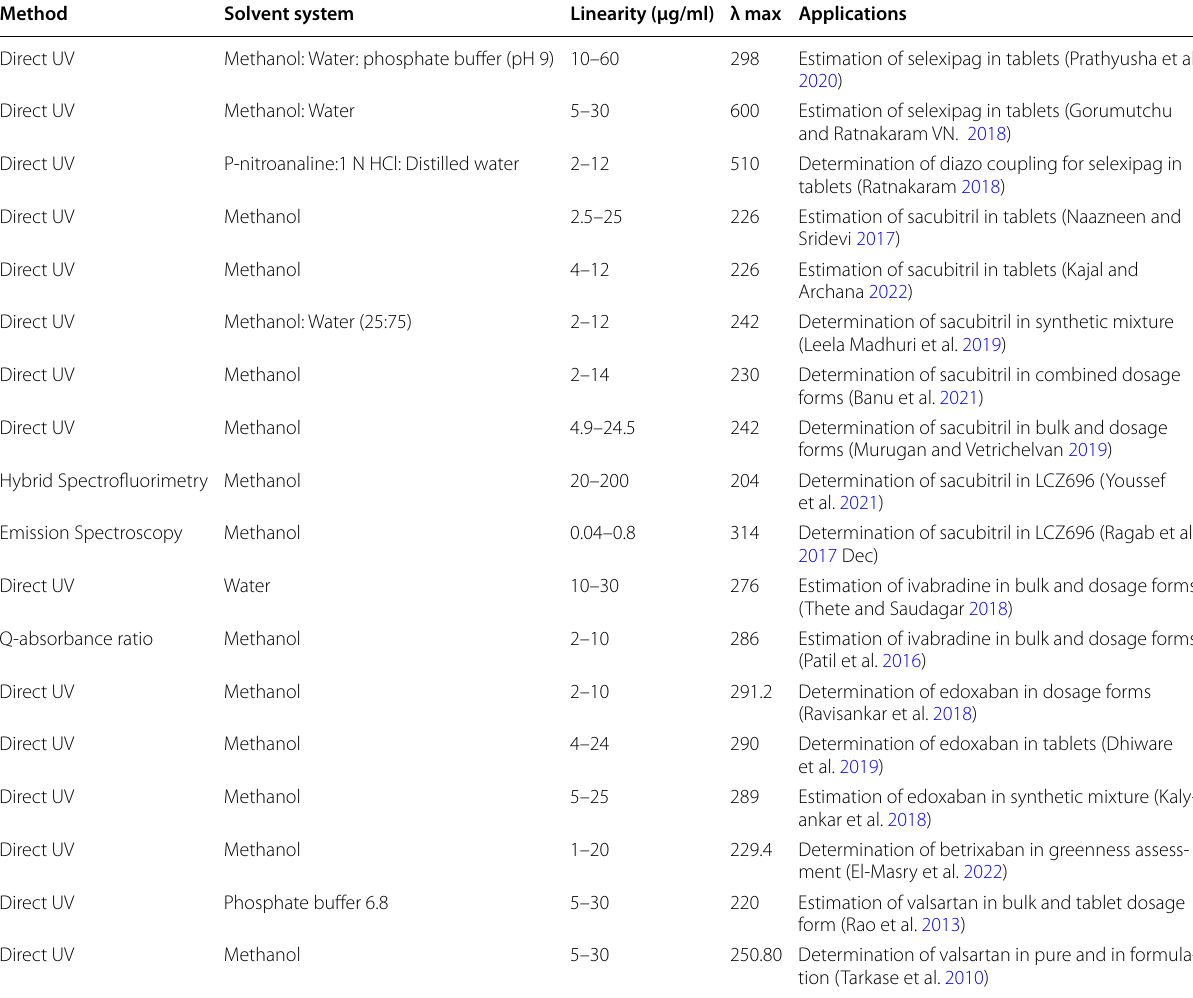
Table 2 Spectrophotometric methods for analysis of FDA-approved treatments for several cardiovascular illnesses from 2015 to June